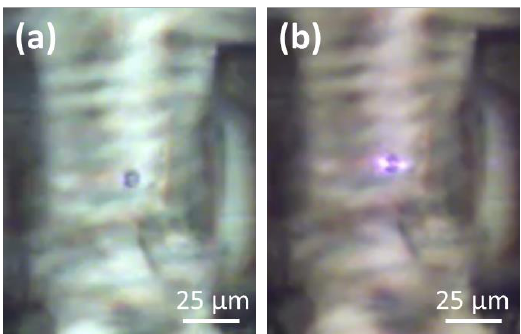
Figure 11. Image of a trapped polystyrene bead (7µm diameter) with the microscope infrared light (IR) light filter inside ( a ) or out ( b ). In ( b ) the scattering visible on both sides of the bead demonstrates the trapping due to the light from the optical fibres.